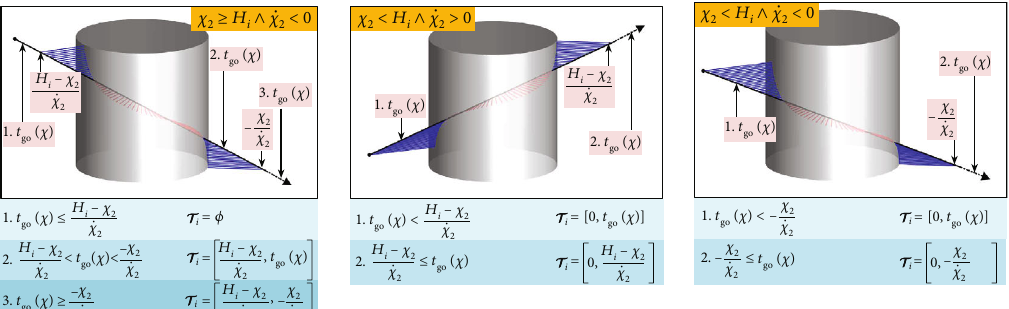
Figure 4: Situations related to the feasible range of time.